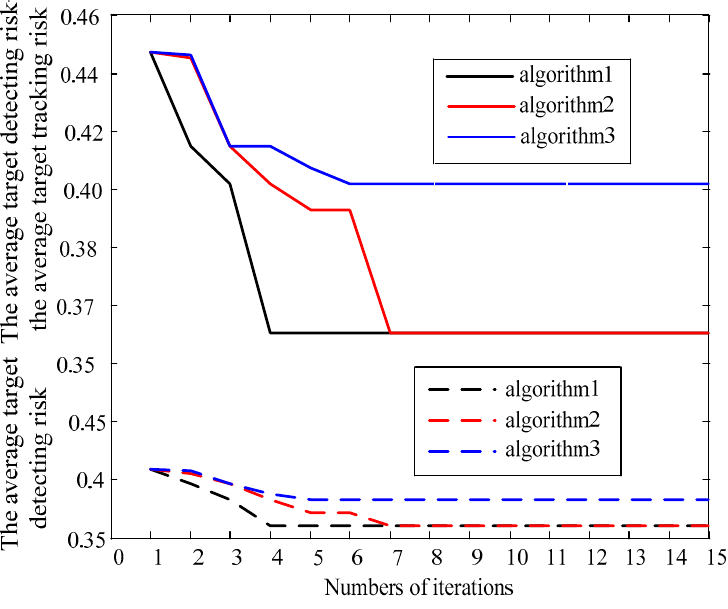
Figure 8. Algorithm iteration curves.